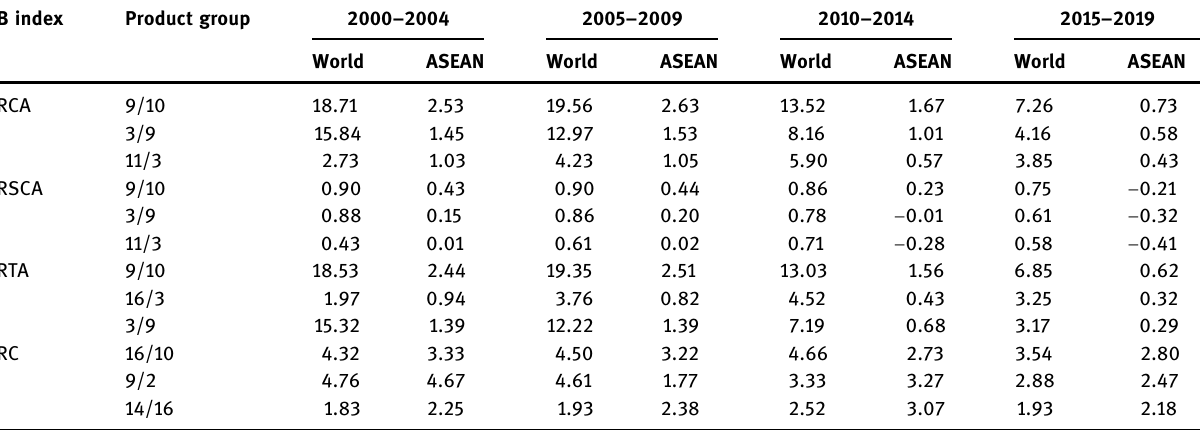
Table 13: The three highest Balassa indices of Vietnam at World and ASEAN level, 2000 –